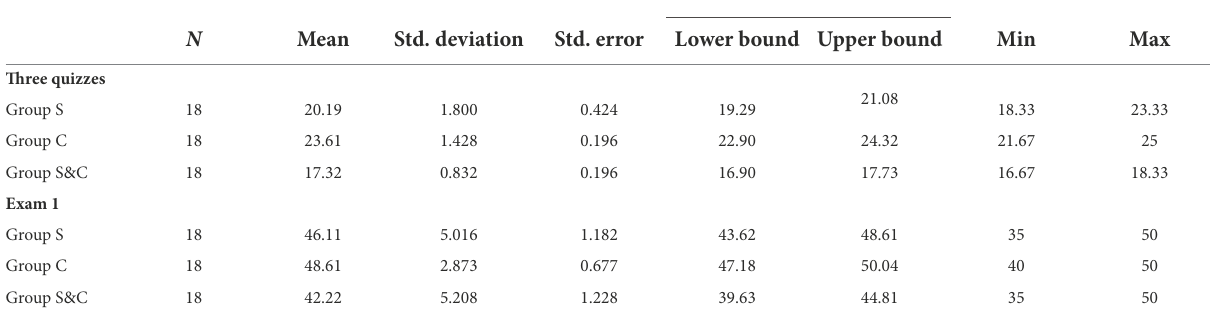
TABLE 2 Means, standard deviations, and range of acquisition of declarative knowledge for phase